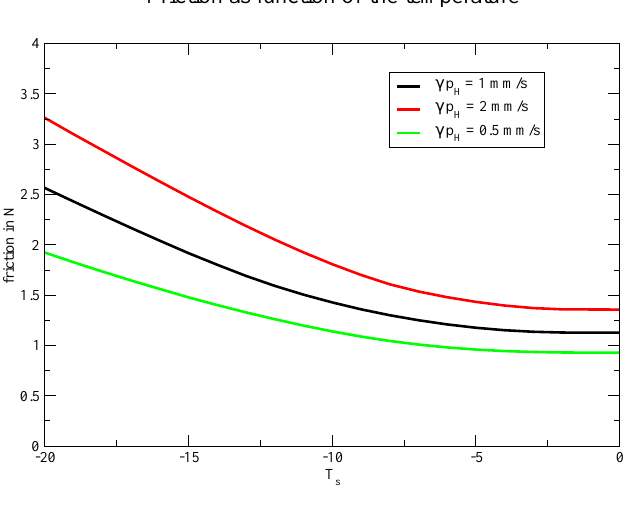
Figure 7: The friction for skating conditions as function of the